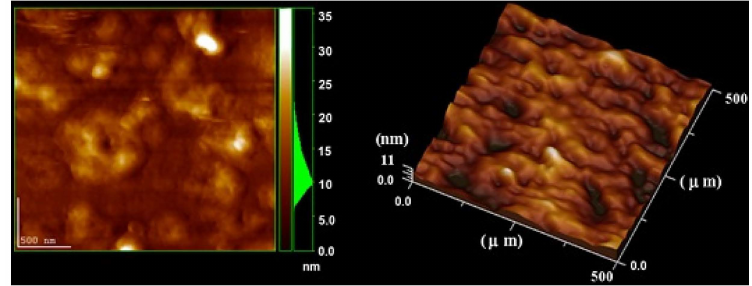
Figure 13. AFM micrographs of 4b double-layer film: Frontal and 3D views,